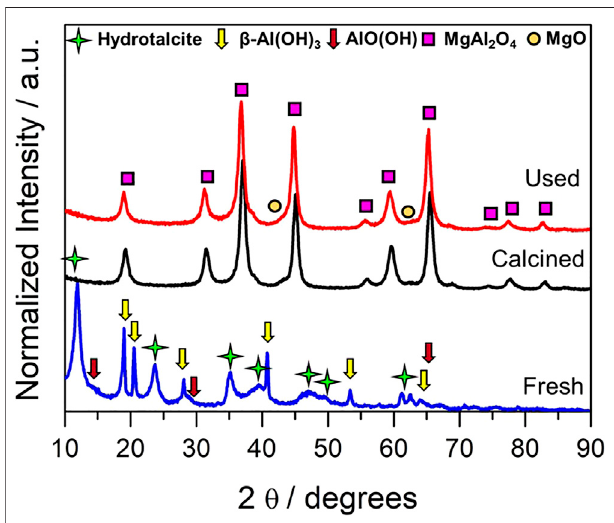
FIGURE 1 | XRD pattern of hydrotalcite precursor (fresh), calcined, and spent mixed oxide catalysts. Note: a.u. is equivalent to arbitrary units.